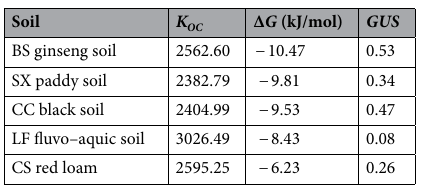
Table 5. Adsorption constants, Gibbs free energy, and ground ubiquity score ( GUS ) of propaquizafop in five different agricultural soils (298.15 K).